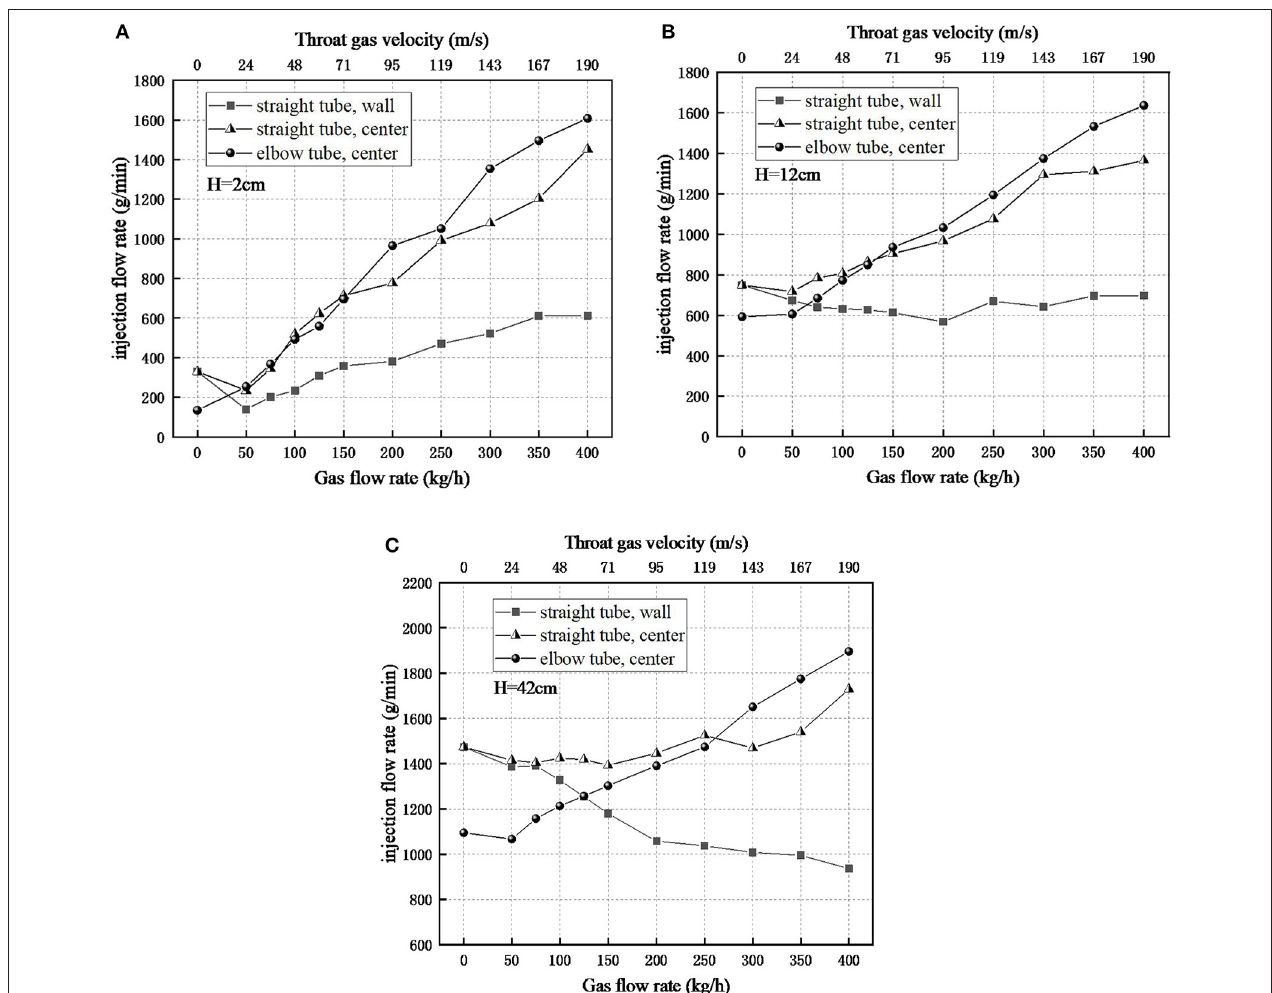
FIGURE 5 | Influence of different throat gas velocity on injection flow rate. (A) H = 2cm, (B) H = 12cm, (C) H =